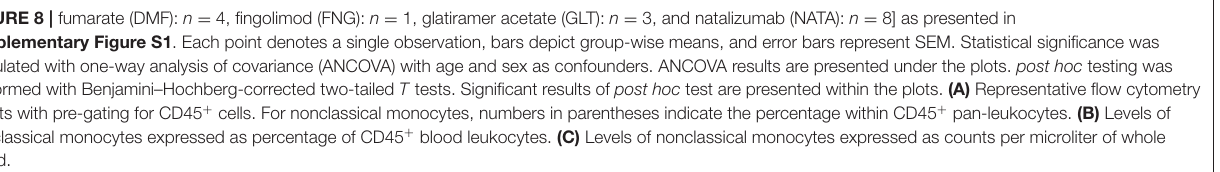
FIGURE 8 | fumarate (DMF): n = 4, fingolimod (FNG): n = 1, glatiramer acetate (GLT): n = 3, and natalizumab (NATA): n = 8] as presented in Supplementary Figure S1 . Each point denotes a single observation, bars depict group-wise means, and error bars represent SEM. Statistical significance was calculated with one-way analysis of covariance (ANCOVA) with age and sex as confounders. ANCOVA results are presented under the plots. post hoc testing was performed with Benjamini–Hochberg-corrected two-tailed T tests. Significant results of post hoc test are presented within the plots. (A) Representative flow cytometry results with pre-gating for CD45 + cells. For nonclassical monocytes, numbers in parentheses indicate the percentage within CD45 + pan-leukocytes. (B) Levels of nonclassical monocytes expressed as percentage of CD45 + blood leukocytes. (C) Levels of nonclassical monocytes expressed as counts per microliter of whole